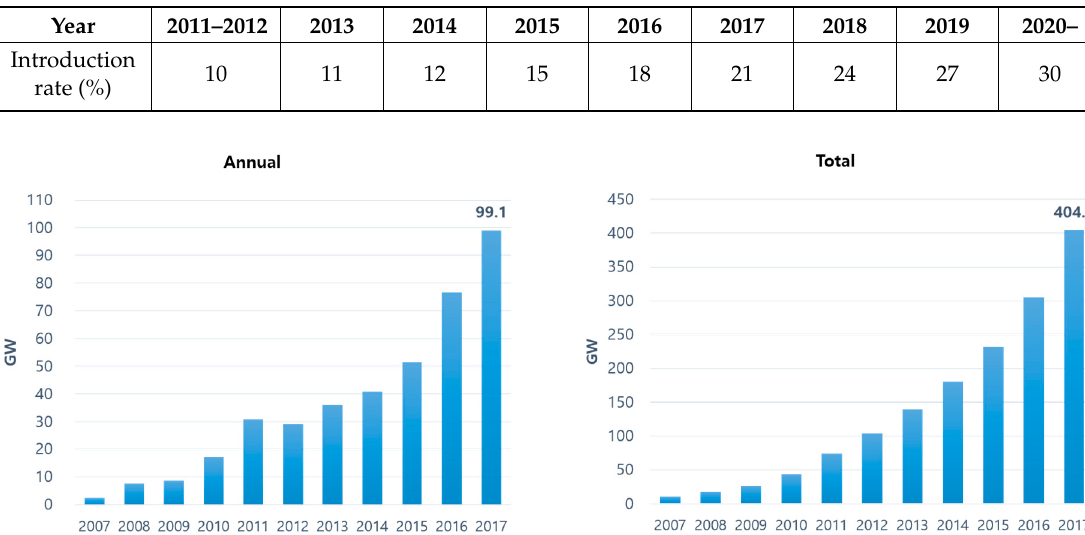
Figure 1. Global annual and total solar PV installed capacity (2007–2017) [4].